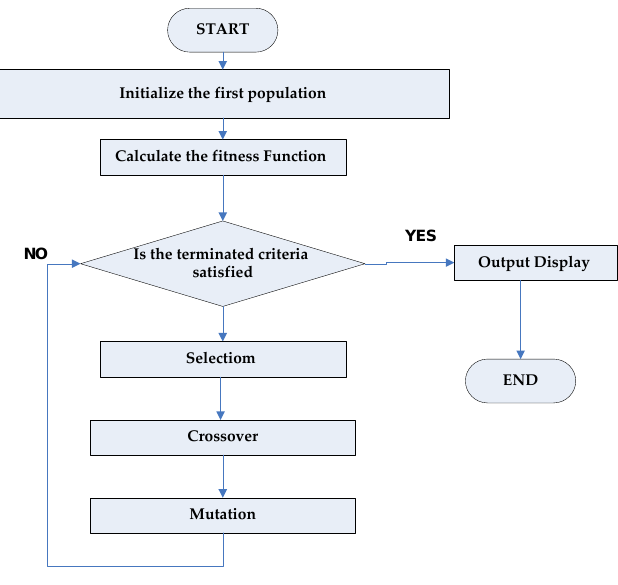
Figure 6. A flowchart of GA.